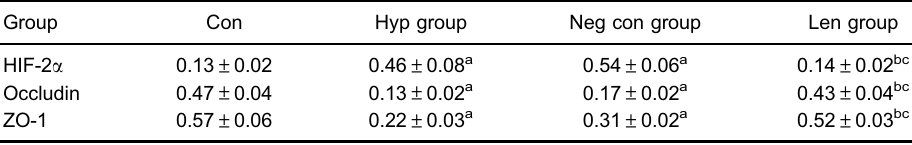
Table 1. Expression of HIF-2 a , occludin, and ZO-1 in different groups.